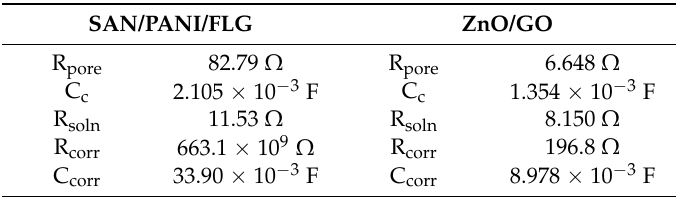
Figure 1. Equivalent cell circuit and EIS Input parameters (EIS-Input Parameters AC voltage: 10 mV; Initial frequency: 1 × 10 5 Hz; Final frequency: 0.2 Hz; Point/decade: 10; Exposed area: 3 × 3 cm 2 ; DC Potential Range: − 250 mV to +250 mV vs. SCE). Table 5. Reap2cpe fitting values of coated samples in sea